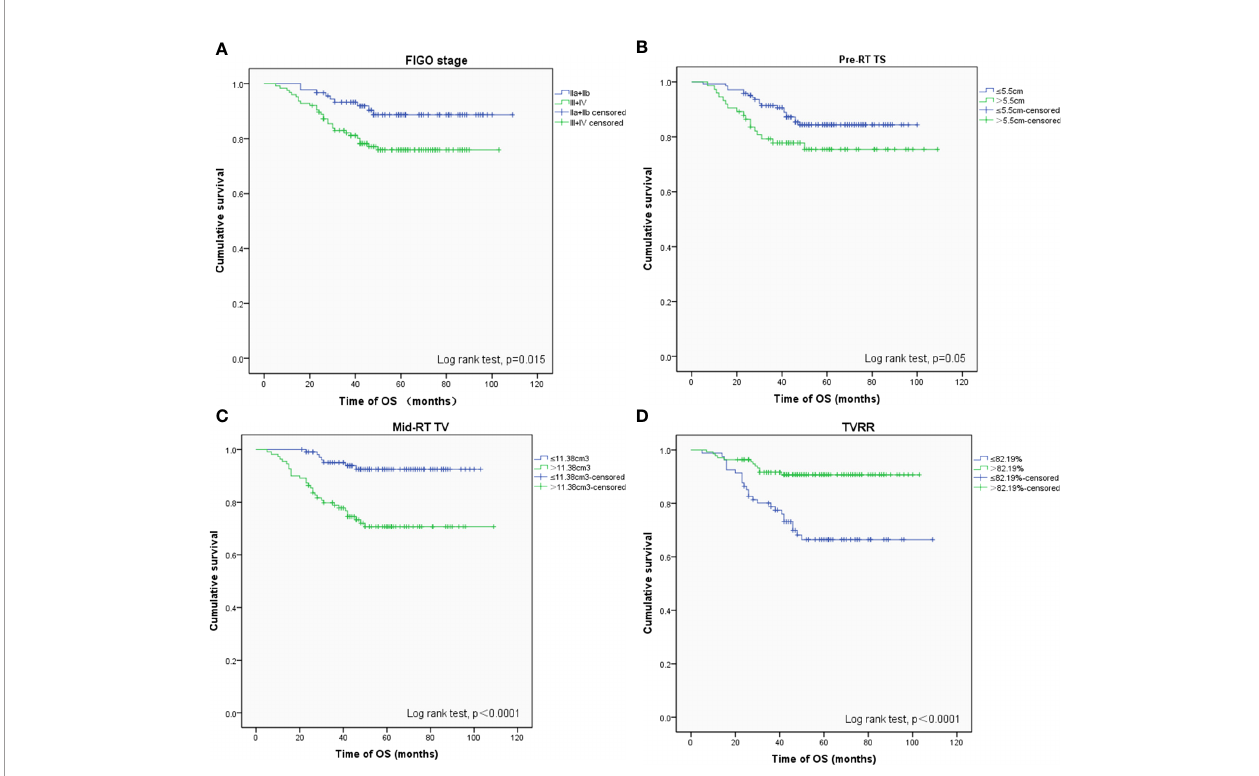
FIGURE 1 | OS-related prognostic factors: (A) FIGO stage (phase II vs III+IV), (B) maximum diameter of tumors before radiotherapy ( ≤ 5.5 cm vs > 5.5 cm), (C) volume of tumors after external irradiation ( ≤ 11.38 cm 3 vs > 11.38 cm 3), (D) reduction rate of tumors ( ≤ 82.19% vs > 82.19%).